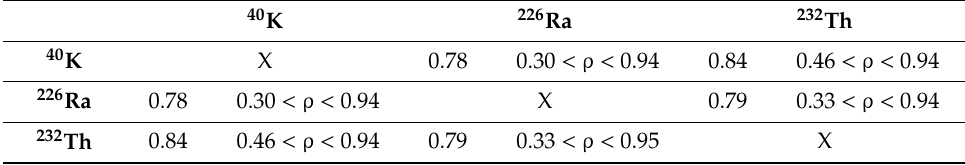
Table 5. Correlation matrix for specific activity concentration of 40 K, 226 Ra and 232 Th with 90% confidence interval for ρ . 40 K 226